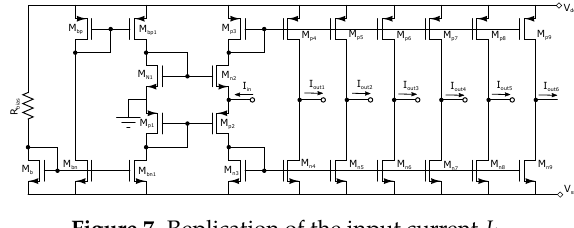
Figure 7. Replication of the input current I in . Table 4. Sizes of the current mirror shown in Figure 7.